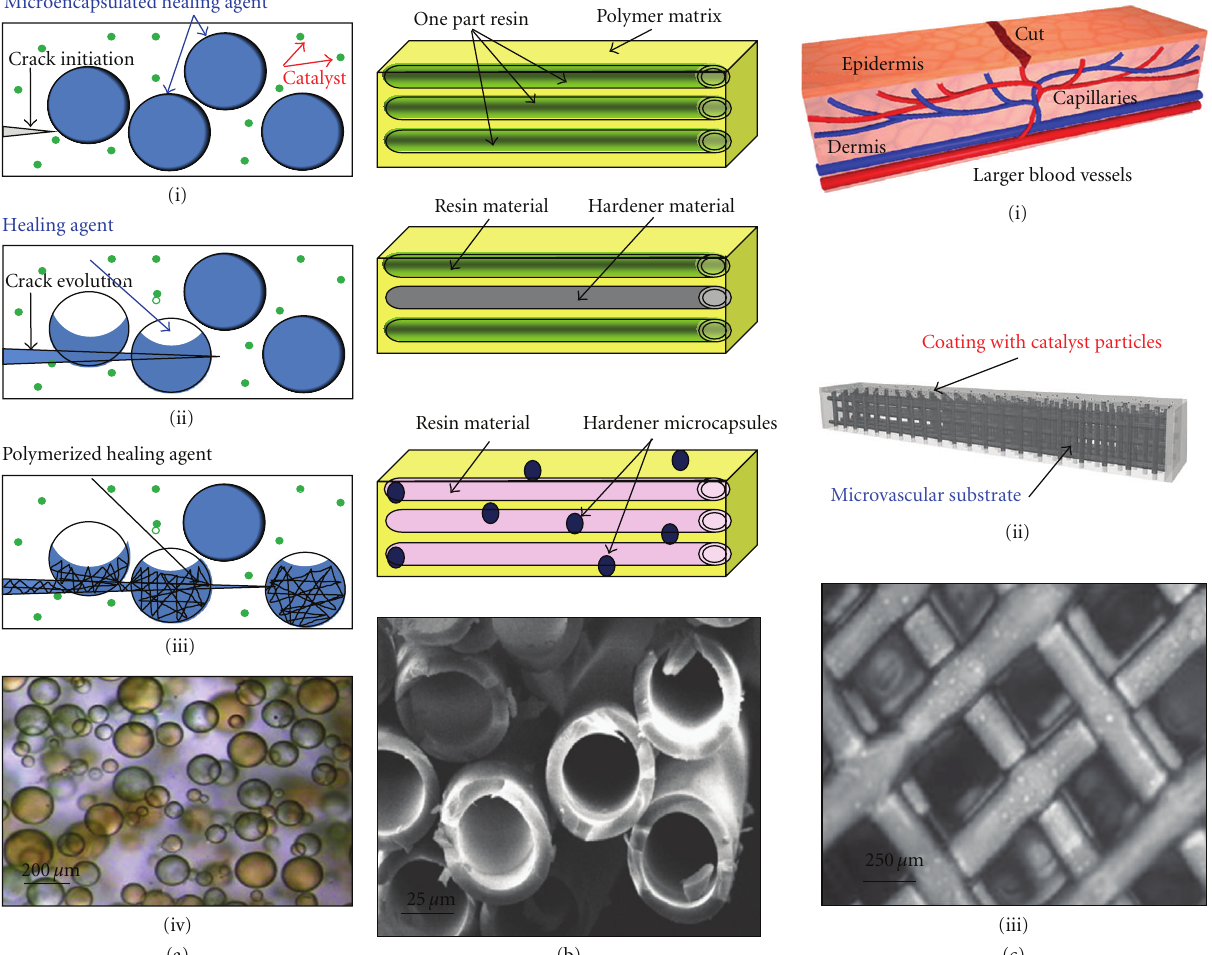
Figure 3: (a) Autonomic healing concept incorporating encapsulated healing agent and embedded catalyst particles in a polymer matrix; (i) damage event causes crack formation in the matrix; (ii) crack ruptures the microcapsules, releasing liquid healing agent into crack plane; (iii) healing agent polymerizes upon contact with embedded catalyst, bonding crack closed; (iv) typical SEM image of the urea-formaldehyde microcapsules containing dicyclopentadiene prepared by emulsion in situ microencapsulation, adapted from [35]. (b) (i) Schematic diagram of smart repair concepts considered for hollow glass fiber polymer matrix composites. Use single-part, two-part resin and hardener, or resin with a catalyst/hardener. (ii) Typical scanning electron microscopy (SEM) image of the hollow glass fiber, adapted from [20]. (c) Biomimetic microvascular self-healing. (i) Schematic diagram of a capillary network in the dermis layer of skin with a cut in the epidermis layer (ii) Schematic diagram of the self-healing structure composed of a microvascular substrate and a brittle epoxy coating containing embedded catalyst, adapted from [23]. (iii) Optical image of the 3D microvascular network embedded in an epoxy matrix (Credit Photo D.